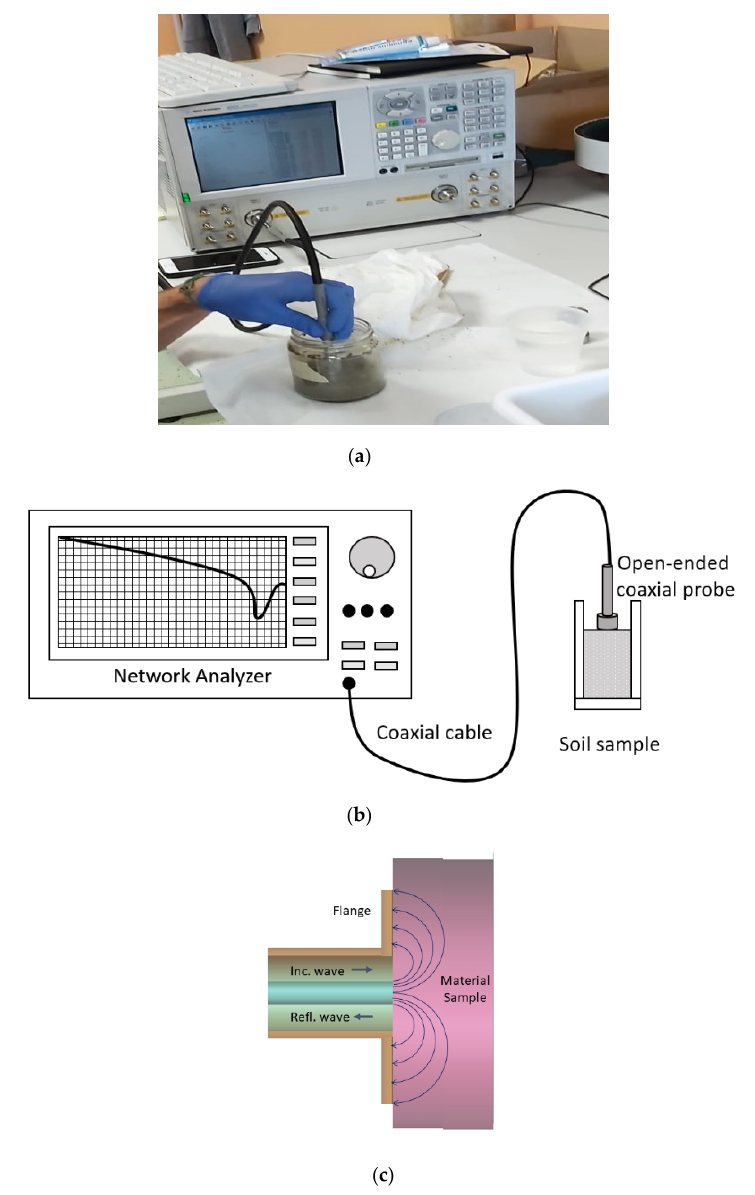
Figure 3. Network analyzer and dielectric probe measuring the permittivity of contaminated soil: ( a ) instrument, ( b ) apparatus scheme, and ( c ) open-ended coaxial probe scheme.